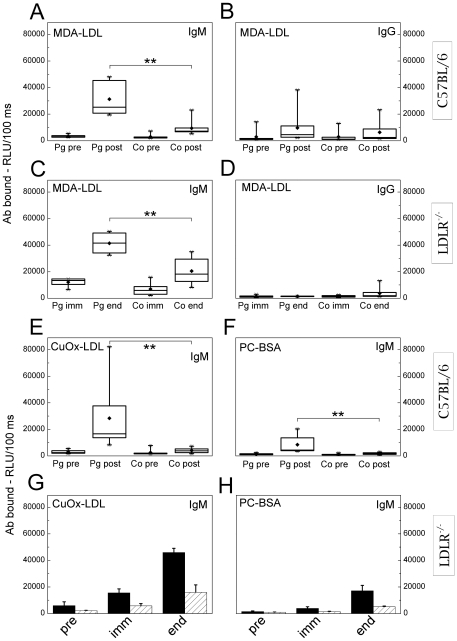
Mouse plasma IgM and IgG binding to MDA-LDL after immunization with P. gingivalis.C57BL/6 mice were immunized with heat-killed P. gingivalis ATCC33277 (Pg; n = 8) and controls received saline (Co; n = 8). Plasma IgM (A) and IgG (B) to MDA-LDL before (pre) and after immunization (post) were determined with chemiluminescence immunoassay. Each C57BL/6 plasma sample (1∶500) was measured in duplicate and an average for each individual was calculated. LDLR−/− mice were immunized with killed P. gingivalis (3 strains mixed) (Pg; n = 7) and controls received PBS (Co; n = 8). Plasma IgM (C) and IgG (D) to MDA-LDL after the second booster immunization (imm) and after the HFD (end) were determined. Each LDLR−/− plasma sample (1∶1000) was measured in duplicate and an average for each individual in two repeated assays was calculated. Additionally, mouse plasma IgM binding to CuOx-LDL (E, G) and PC-BSA (F, H) was determined. For C57BL/6 mice (E, F) this was done similarly as described for panel A. Plasma samples of LDLR−/− mice (G, H) were pooled between three or four mice (1∶1000) for a single assay, in which the mean ± SD within a group is shown.